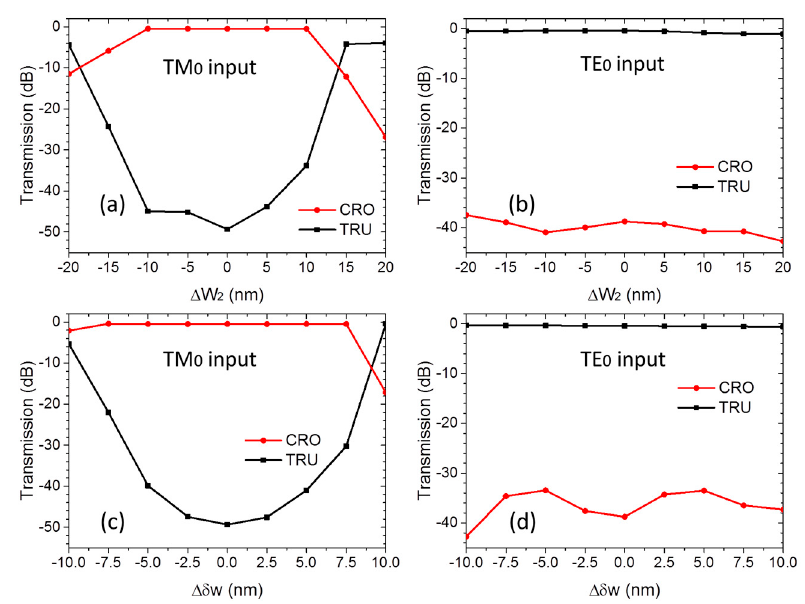
Figure 10. Dependence of transmission on ( a , b ) width deviation Δ W 2 and ( c , d ) corrugation width deviation Δδ w for TE 0 and TM 0 incidence at wavelength of 1.546 μ m.